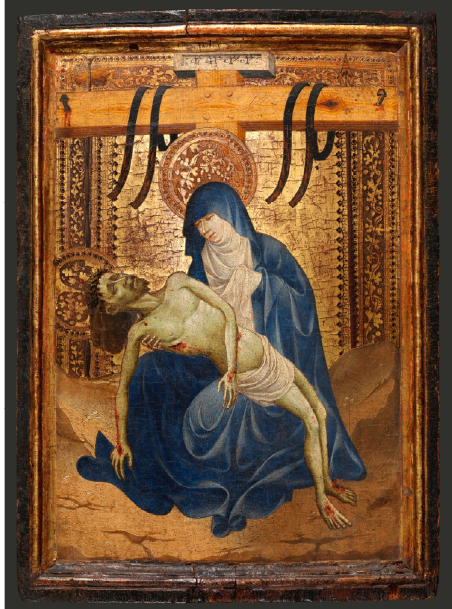
Figure 9. Piety with the instruments of the Passion , Gonçal Peris Sarrià, ca. 1420–1430, Musée du Louvre, París. © Musée du Louvre